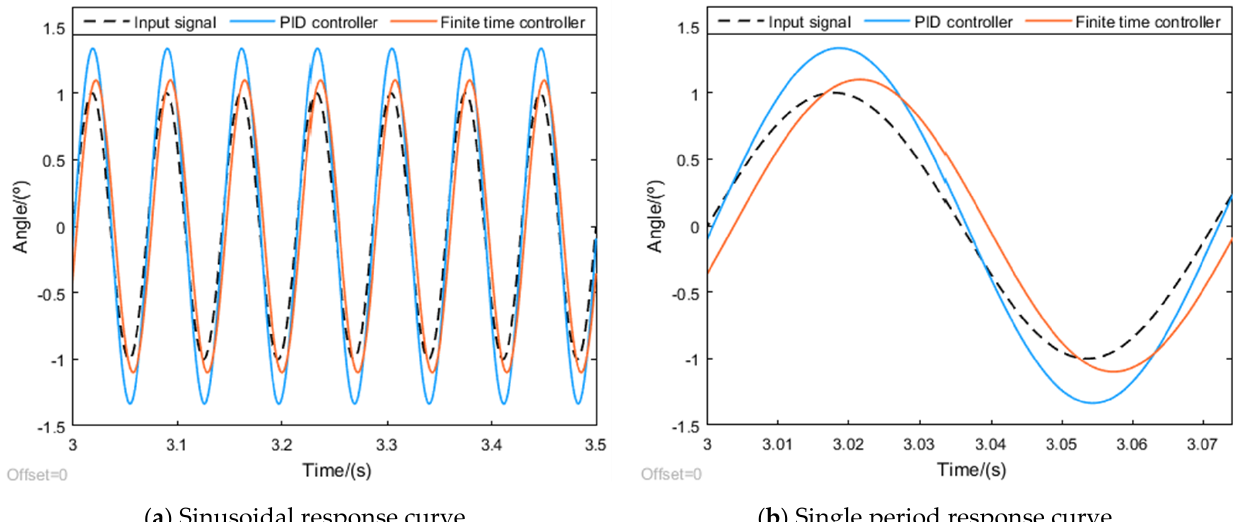
Figure 13. Finite-time composite control response curve of the motor system with 14 Hz and 1° sinusoidal signal. Table 1. Comparison chart of system performance with 1 ◦